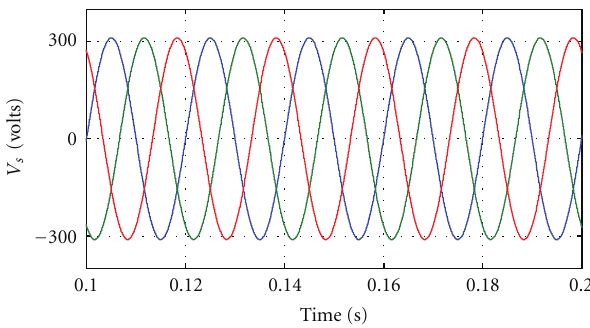
Figure 8: Ideal supply voltage waveform.